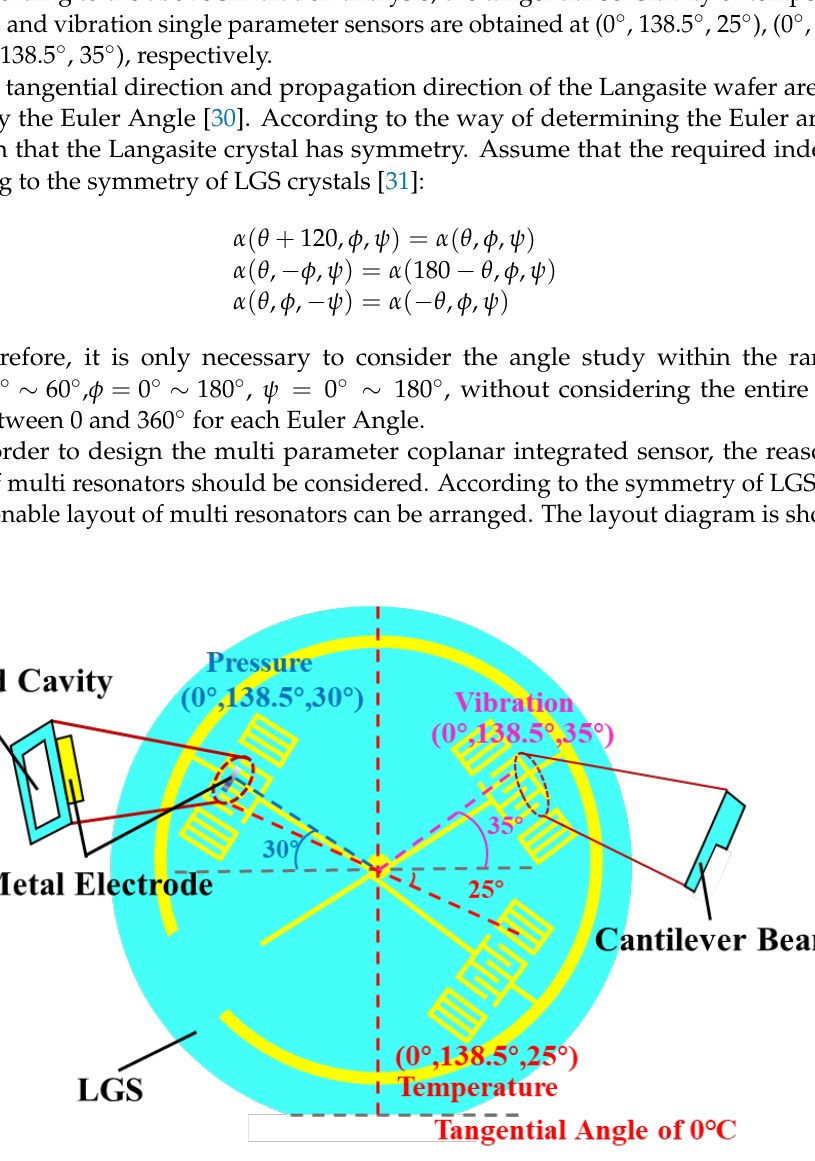
Figure 9. Frequency division design diagram of each parameter.